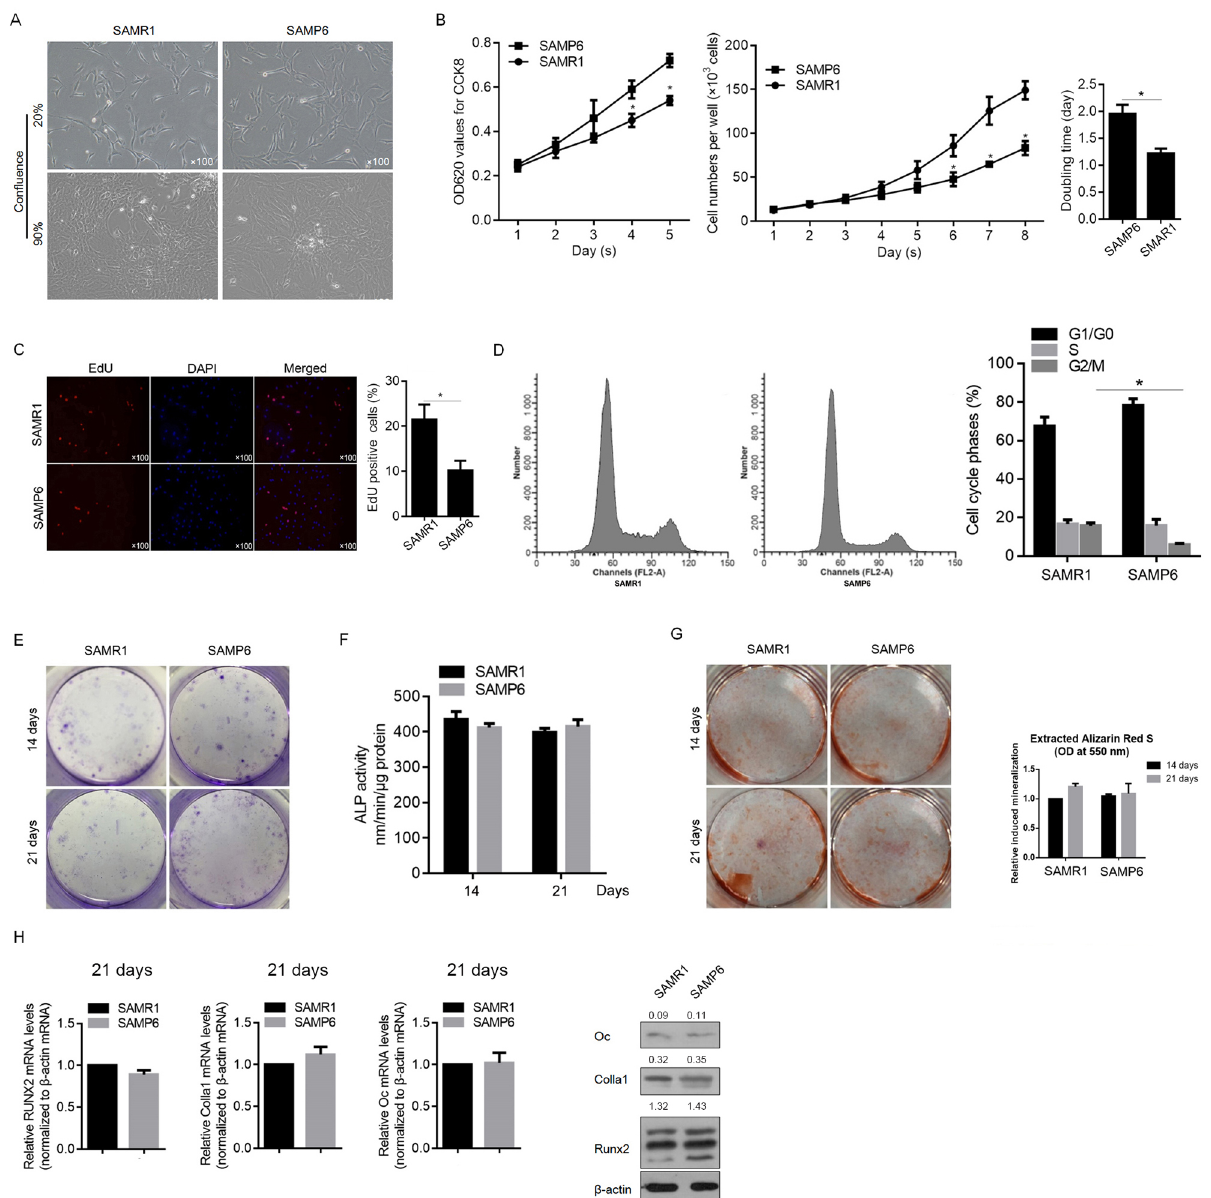
Fig 1. Osteoblasts in SAMP6 mice presented weaker cell proliferating activity than SAMR1. (A) Morphology of SAMR1 and SAMP6 osteoblasts. (B) The CCK-8 assay was performed to detect the cell viability of osteoblasts from SAMP6 or SAMR1 mice. (cid:3) P < 0.05 vs. SAMR1. (C) EdU staining was performed to detect proliferating osteoblasts from SAMP6 or SAMR1 mice. (D) PI staining was performed to analyze the distribution of the cell cycle phases of osteoblasts from SAMP6 or SAMR1 mice. Osteoblasts were cultured for 14 or 21 days and were stained for ALP (E) or assayed for ALP activity (F). (cid:3) P < 0.05 vs. SAMR1. (G) Alizarin red S staining was performed to detect the mineralization of osteoblasts. The quantitative data was presented at right panel. (H) The mRNA and protein levels of Runx2 , Colla I and Oc were analyzed by RT-qPCR (left panel) and semiquantitative Western blotting (right